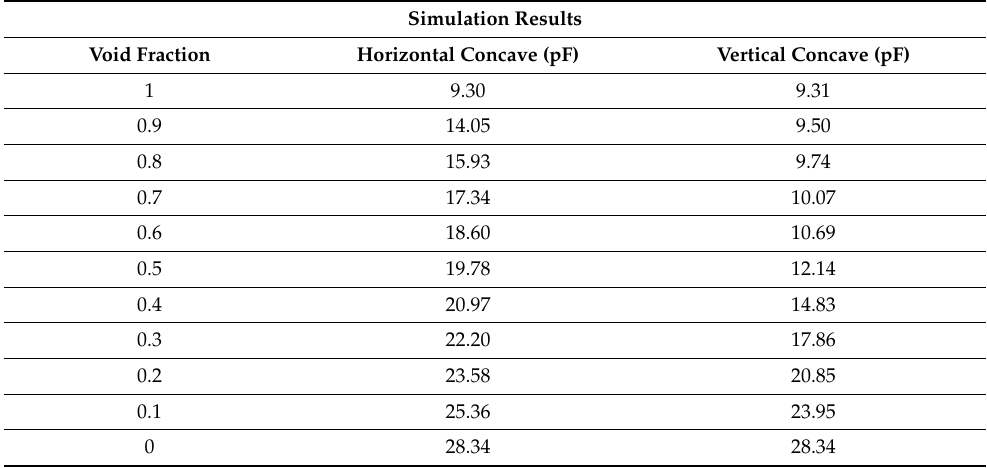
Figure 10. ( a ) Comparing the results of simulation and experiments for double-ring configuration, ( b ) Comparing the results of simulation and experiments for vertical concave configuration, ( c ) Comparing the results of simulation and experiments for horizontal concave configuration. Table 4. Measured capacitance values in different void fractions for concave sensor in